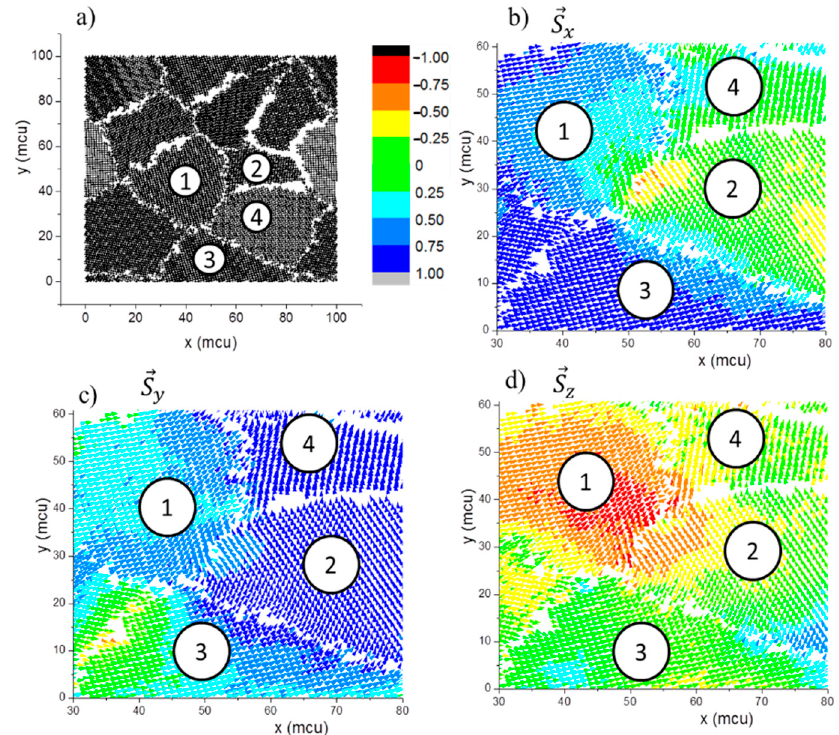
Figure 5. The xy middle plane representation at thickness 10muc of ( a ) structural distribution and ( b ), ( c ) and ( d ) colour map of a final state for Sx, Sy and Sz, respectively. Returning to Figure 4, at a thickness of 14 muc, |(cid:104) S z (cid:105)| is lower than (cid:104)| S z |(cid:105) and out of its error bars; this represents the beginning of a mismatch between the grain moments in opposite z directions, and the presence of a single-domain tendency per grain (or small set of grains). At a thickness of 16muc, the low value of (cid:104)| S z |(cid:105) indicates that most of the spin moments are in-plane aligned. This indicates the strongest dipolar interaction influence.